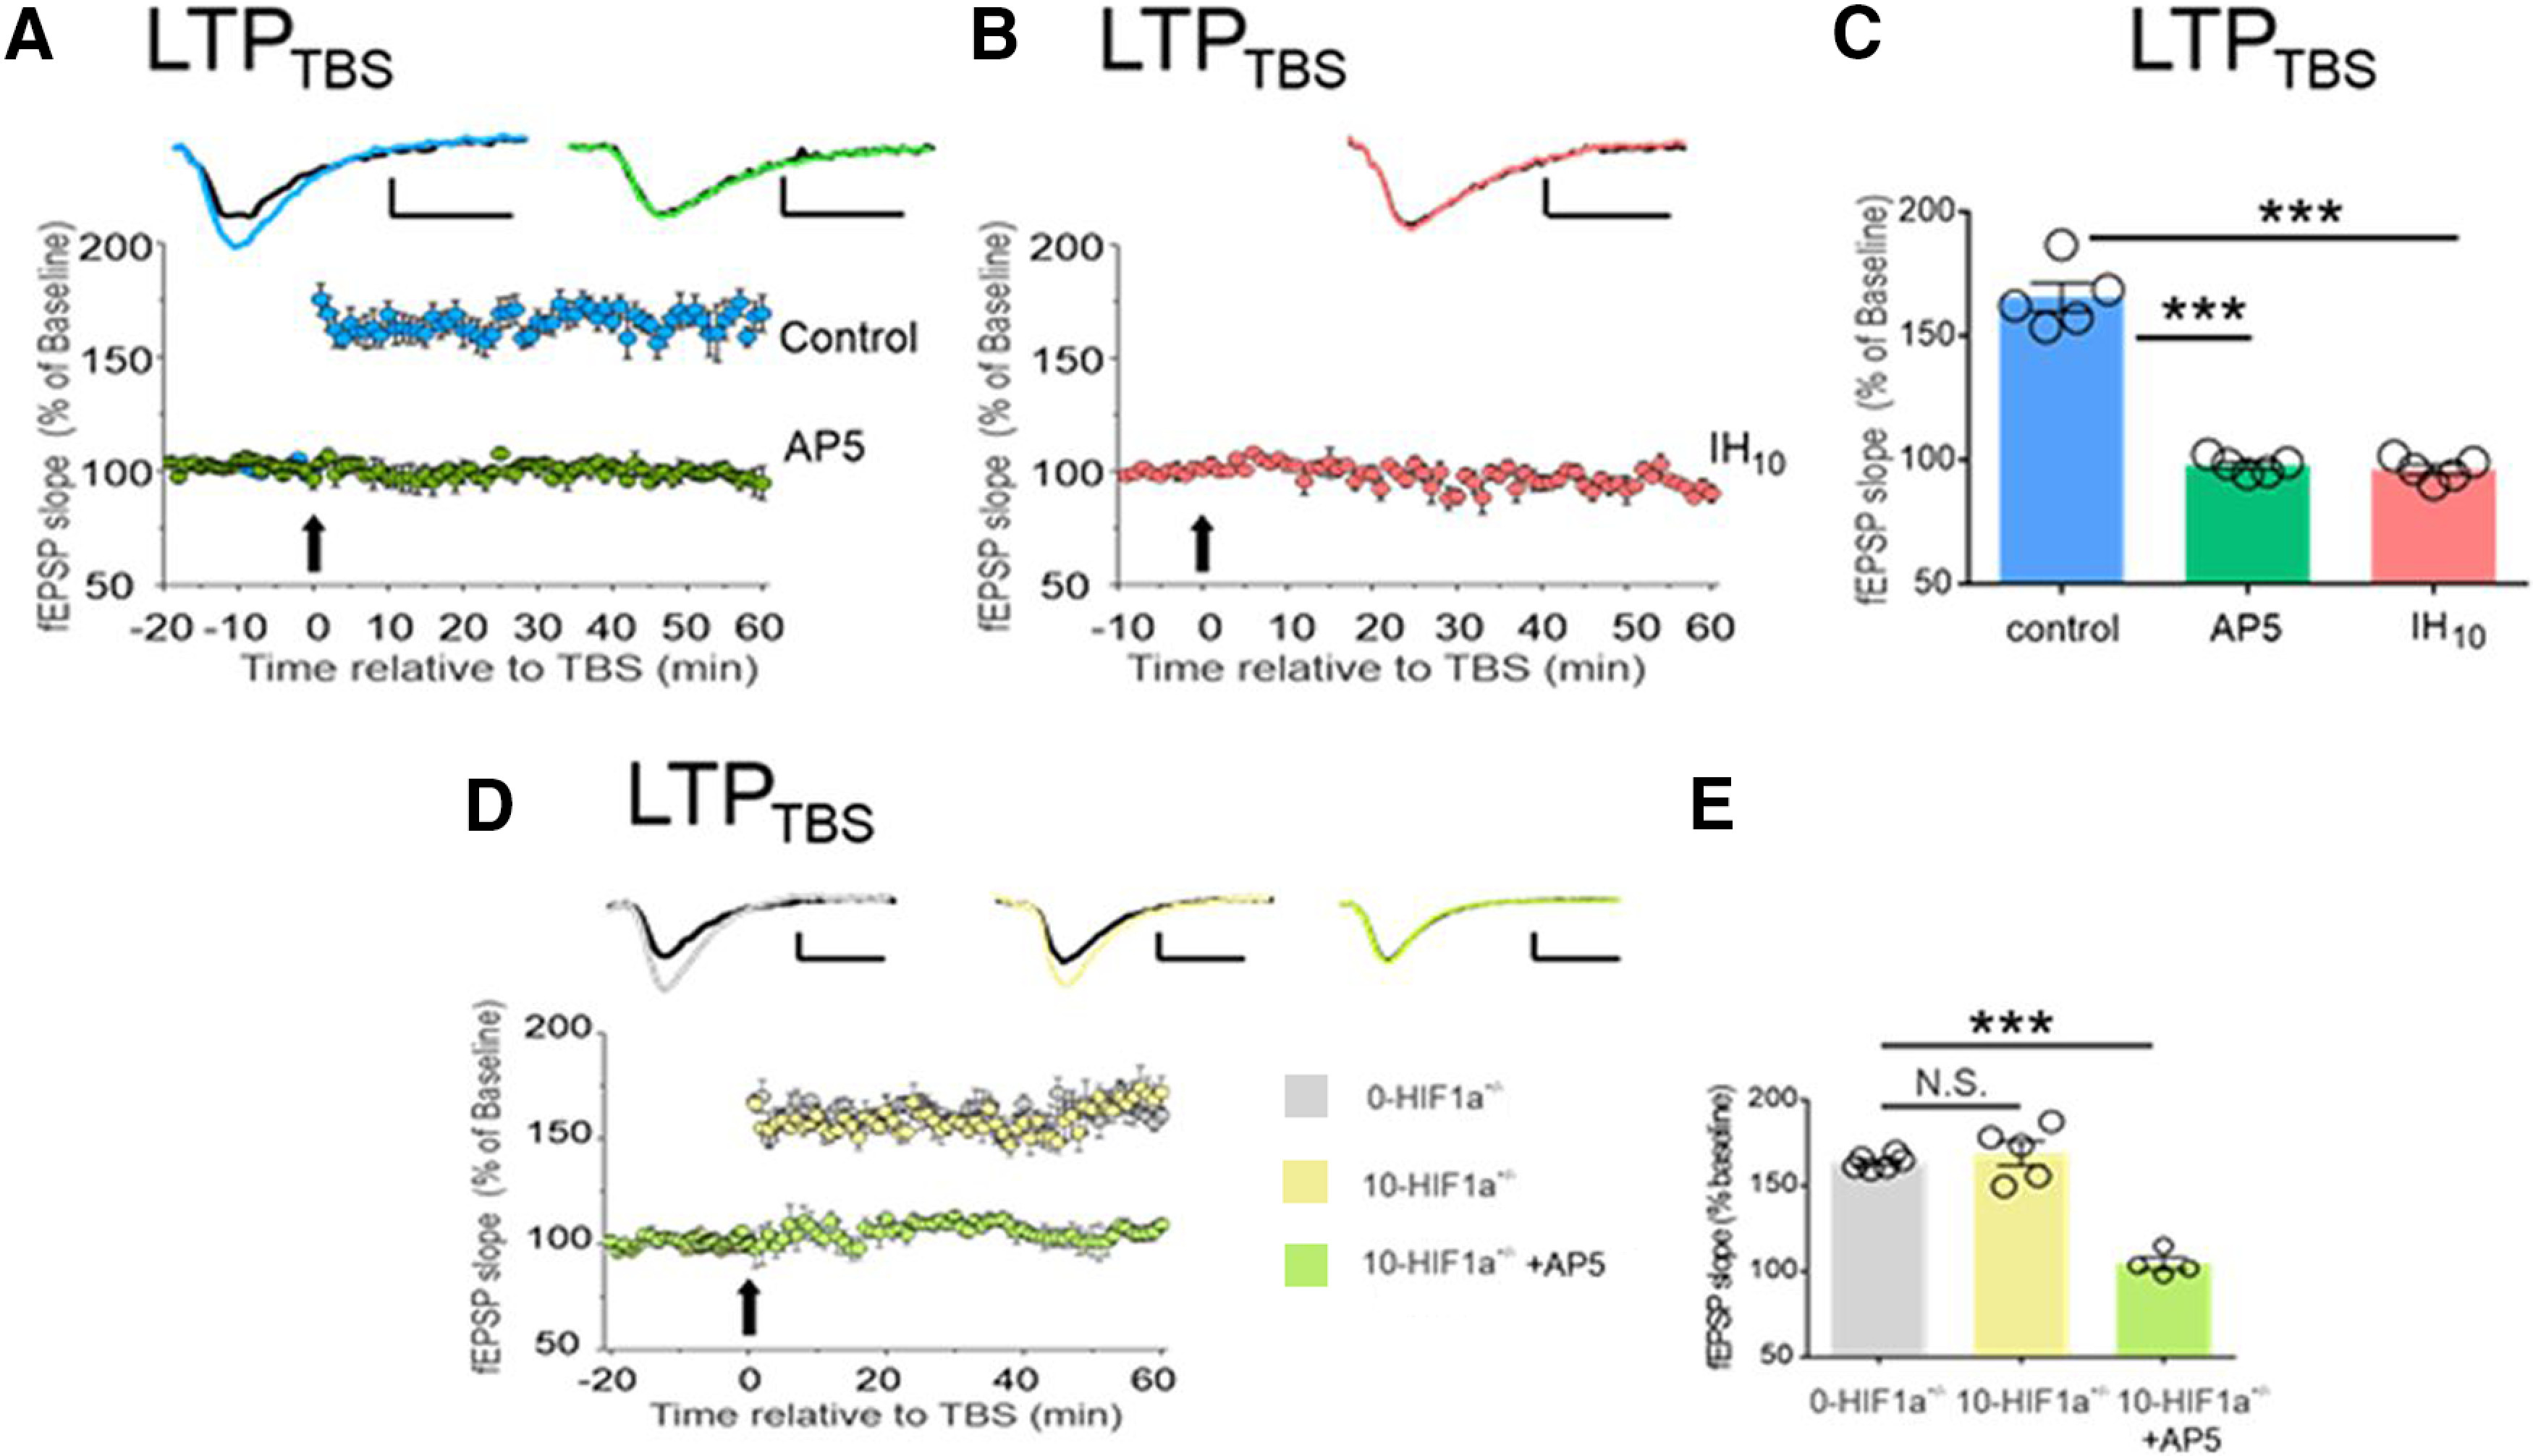
IH suppresses NMDAr-dependent synaptic potentiation in WT hippocampal slices, but NMDAr-dependent LTP is unaffected by IH in the hippocampal slices from HIF1a+/−mice. A, LTPTBS is readily evoked in control (light blue) and is completely blocked by AP5 (light green). B, LTPTBS is present following IH (pink). C, Post hoc comparison of LTPTBS magnitude (60 min following TBS) show significant effects of AP5 or IH10 compared with the control condition. D, LTPTBS was evoked in 0-HIF1a+/− (light gray), 10-HIF1a+/− (light yellow), and 10-HIF1a+/− + AP5 (light green) groups. No difference was found when comparing LTPTBS magnitude of 0-HIF1a+/− and 10-HIF1a+/− mice. Representative traces illustrate baseline (black) and 60 min following HFS (colored trace). Scale bars: 0.2 mV/10 ms. In experiments using AP5, electrophysiological recordings began at 20 min before eliciting LTP (i.e., t = −20), while AP5 was applied 10 min before eliciting LTP (i.e., t = −10). For all experiments, the arrow represents the electric protocol (TBS); ***p < 0.01; N.S., p > 0.05. (Adapted from Figure 2 in Arias-Cavieres et al., 2020.)